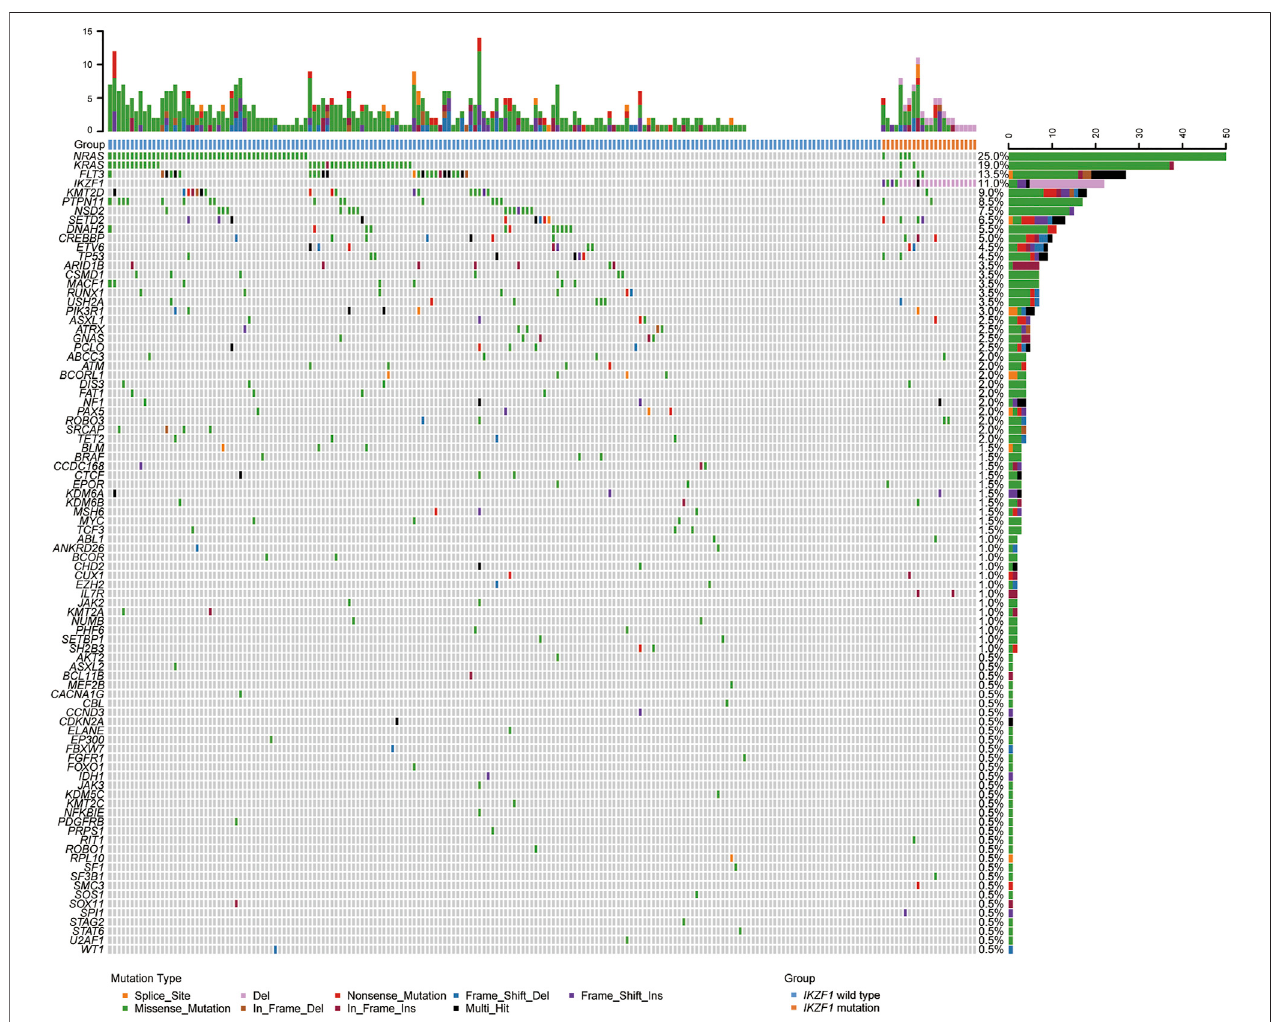
FIGURE 1 | Overview of the gene mutations identi fi ed by targeted next-generation sequencing and multiplex ligation-dependent probe ampli fi cation in 200 B-ALL patients. Heatmap shows the speci fi cmutationsin each patientbasedon differentgene mutation types, includinglarge segmentdeletions,small insertions ordeletions, and single nucleotide